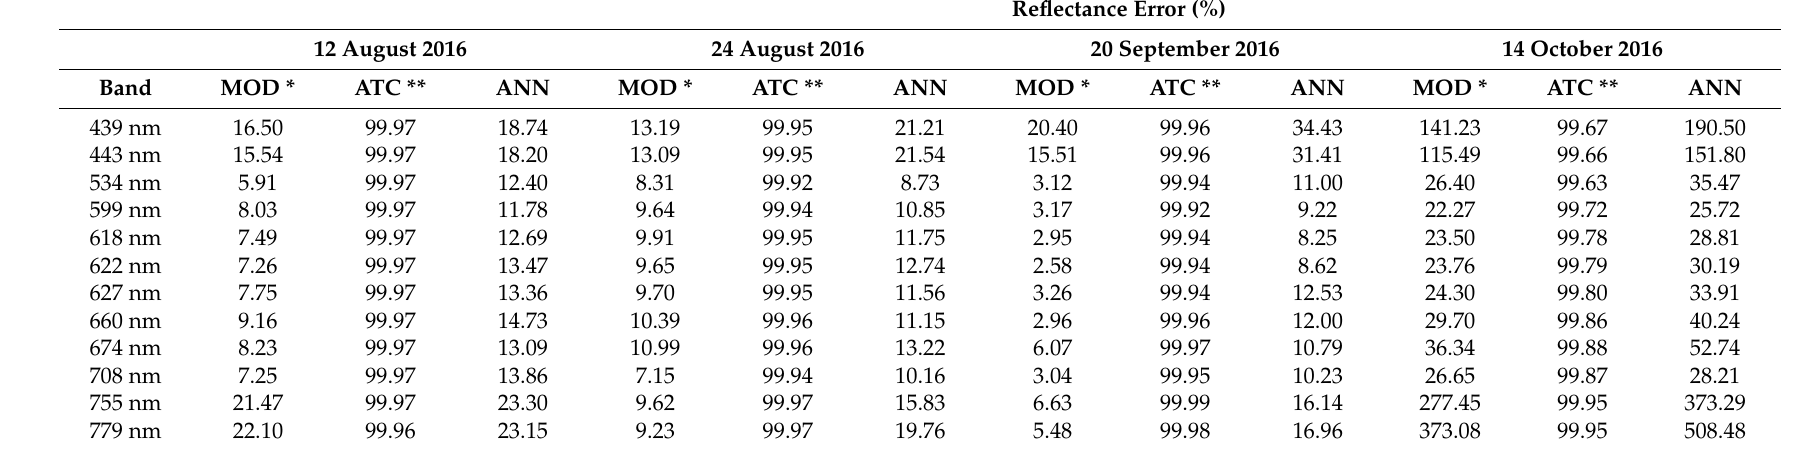
Table 2. Errors of atmospherically corrected